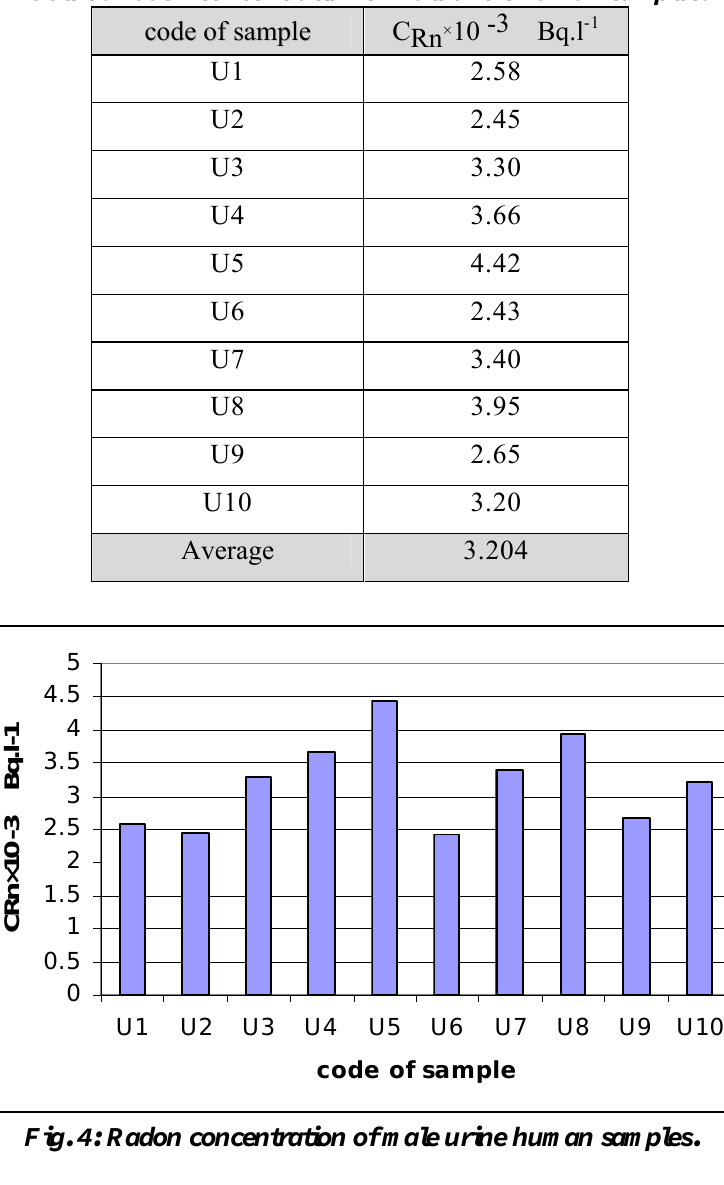
Table 3: Radon concentration in male urine human samples.